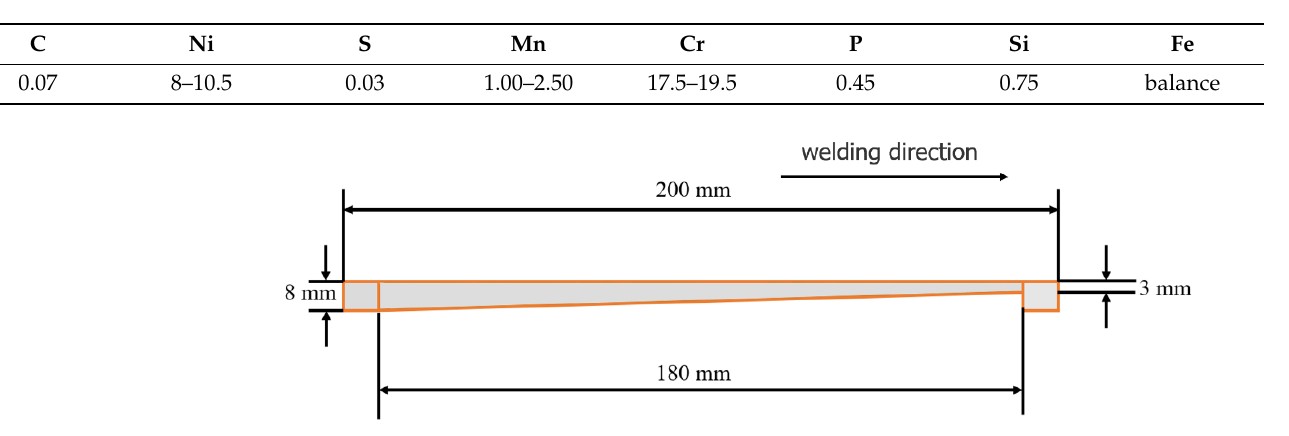
Table 1. 304 Stainless steel chemical composition table (mass fraction, %).